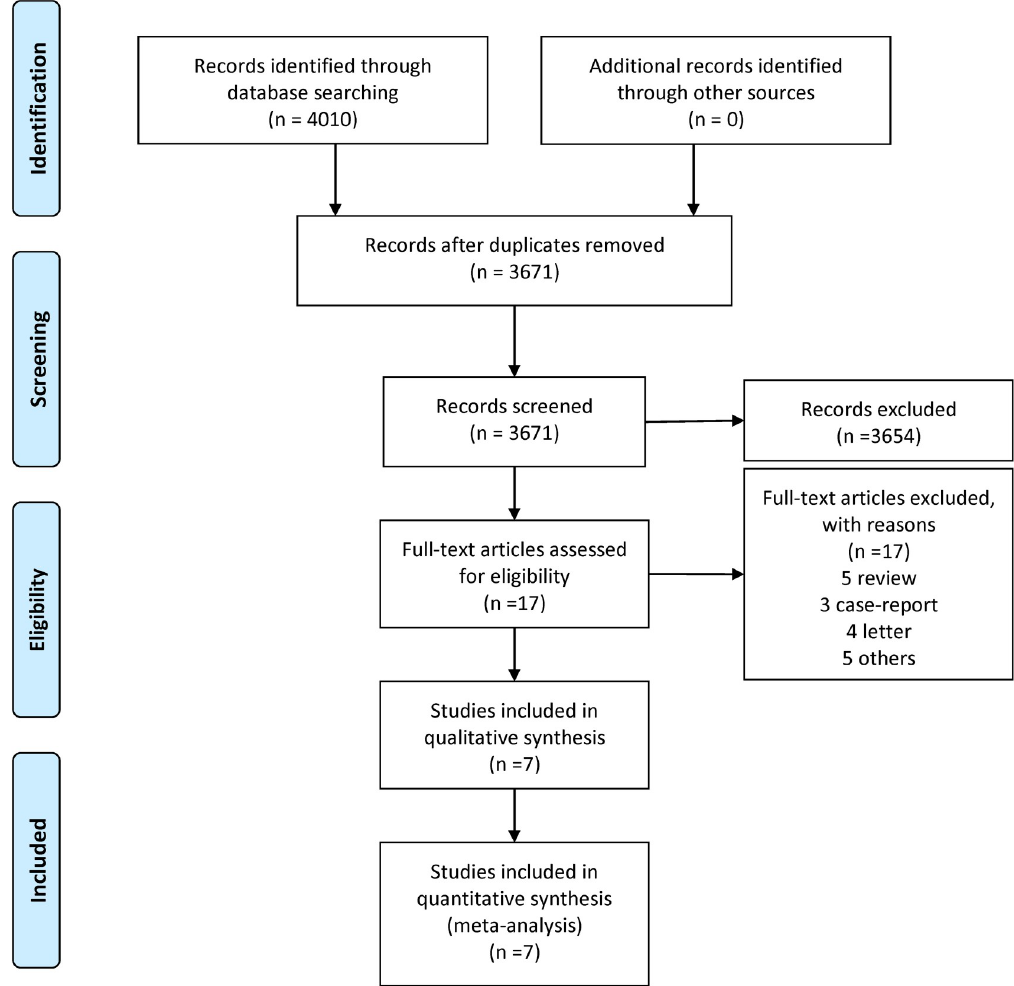
Fig 1. Study selection process: PRISMA flow diagram identifying studies included in the meta-analysis. Abbreviation: PRISMA, Preferred reporting Items for systematic reviews and Meta-analyses.